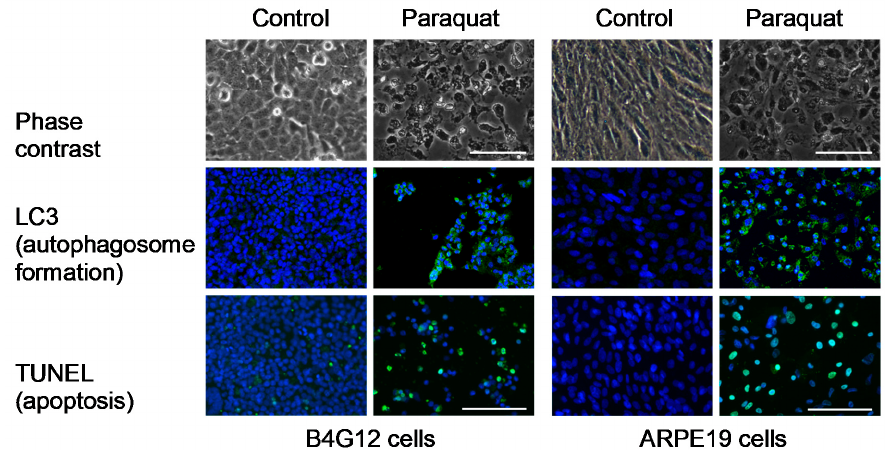
Figure 1. Oxidative stress induces apoptosis and autophagosome formation in B4G12 and ARPE-19 cells. The HCEC cell line (B4G12) and the RPE cell line (ARPE-19) were treated with paraquat (an oxidative stress inducer, 2 mM for ARPE-19, 0.2 mM for B4G12) for five days. Cell morphology was observed using phase-contrast microscopy. TUNEL assay and immunofluorescence of LC3 were performed to examine apoptosis and autophagosome formation (green color). Nuclei were counterstained with Hoechst 33342 (blue color). The scale bars represent 100 µ